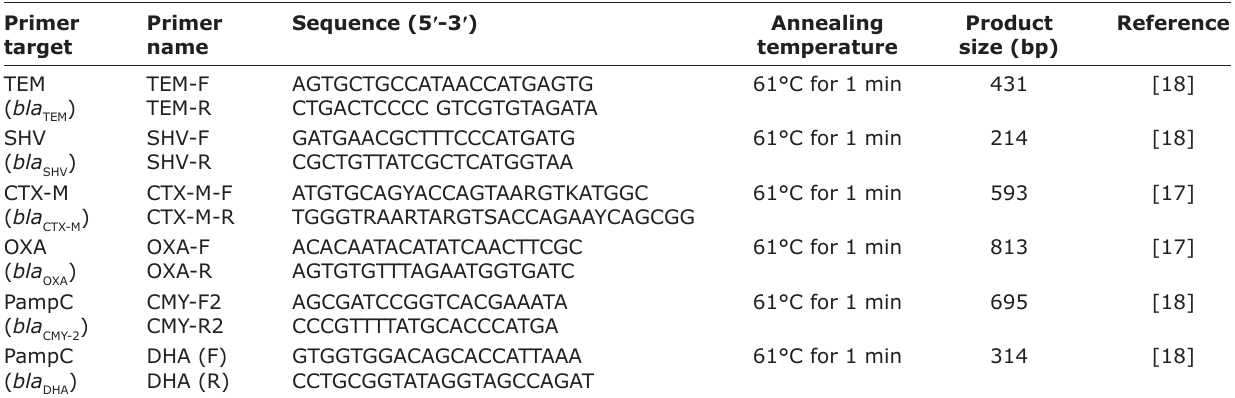
Table-1: Primers used in this study to detect beta-lactamase ( bla ) genes. Primer target